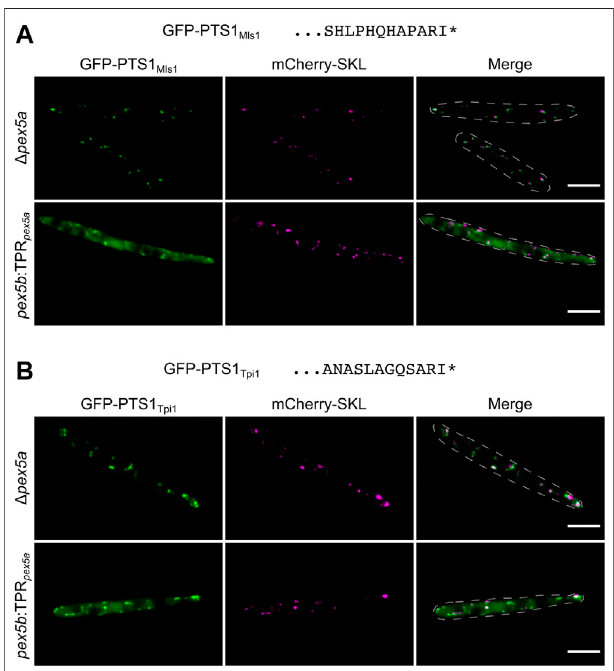
FIGURE 5 | PTS1 motifs with a preference for Pex5b TPRs. Fluorescence microscopic images of indicated strains expressing the peroxisomal marker protein mCherry-SKL (magenta) together with GFP (green) fused to C -terminal dodecamers of Mls1 (malate synthase) (A) and Tpi1 (triosephosphate isomerase) (B) . Both C -terminal dodecamers end on identical tripeptides and show ef fi cient peroxisomal import when the TPR domains of Pex5b were present. Scale bars represent 5